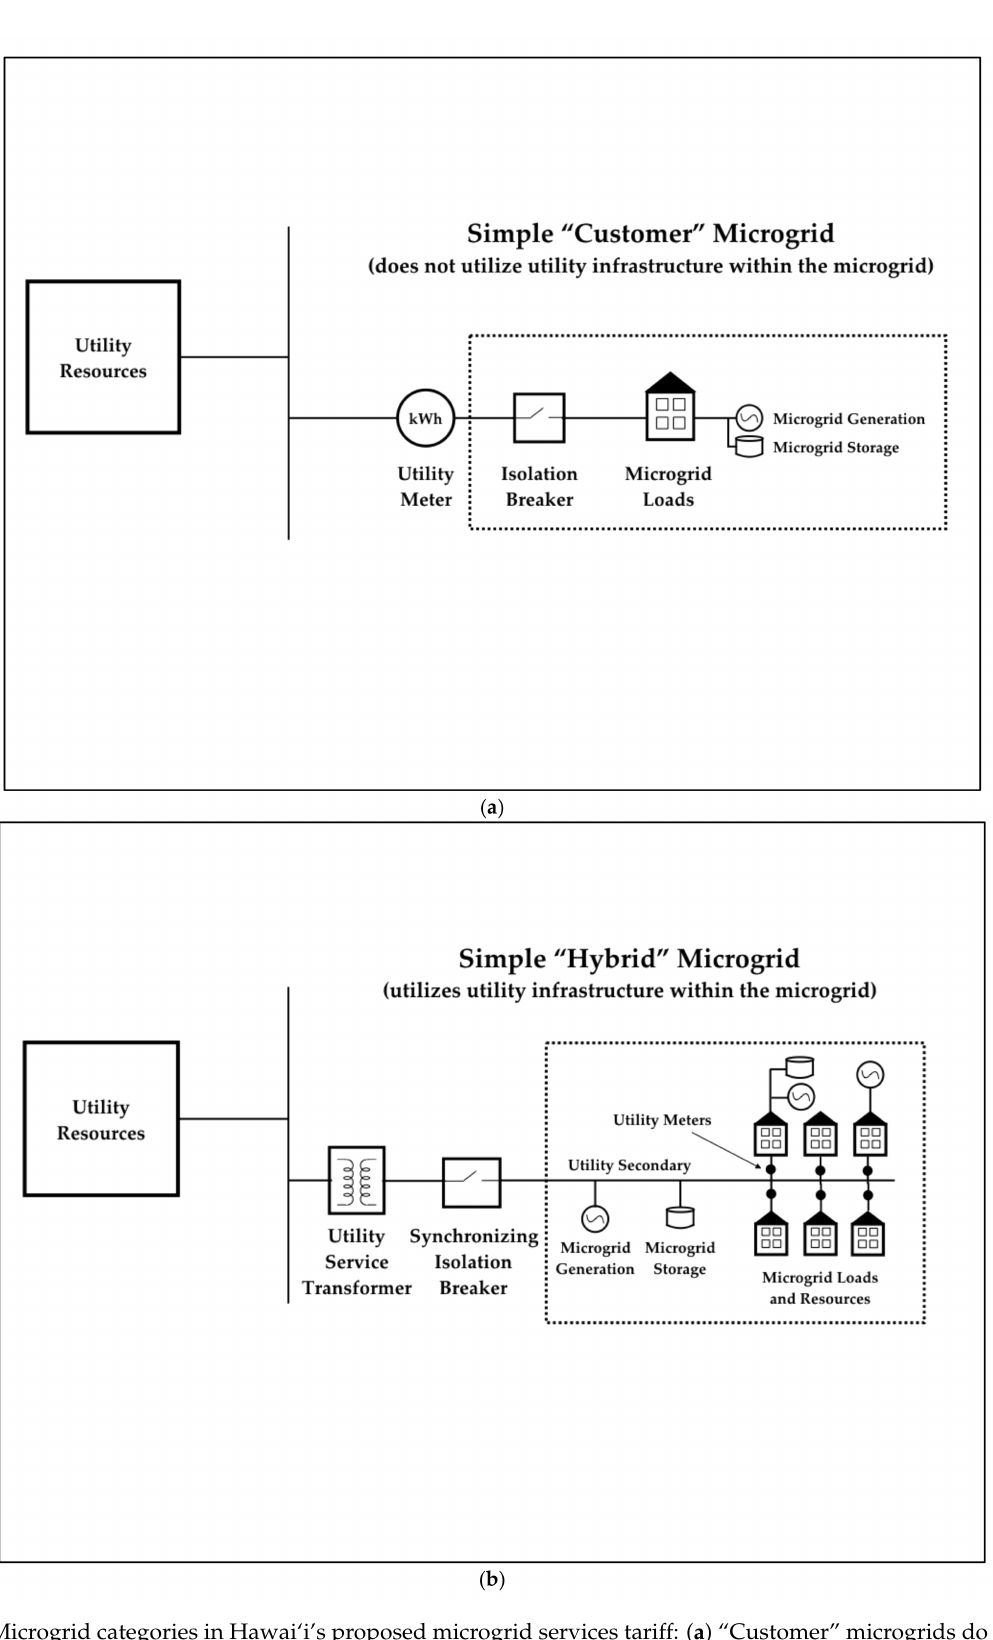
Figure 2. Microgrid categories in Hawai‘i’s proposed microgrid services tariff: ( a ) “Customer” microgrids do not utilize utility infrastructure within the microgrid, and are eligible for standardized interconnection under the tariff and ( b ) “Hybrid” microgrids use both utility and customer infrastructure within the microgrid, and will be required to individually negotiate power purchase agreements with the utility. Adapted from [123] and the Microgrid Resource